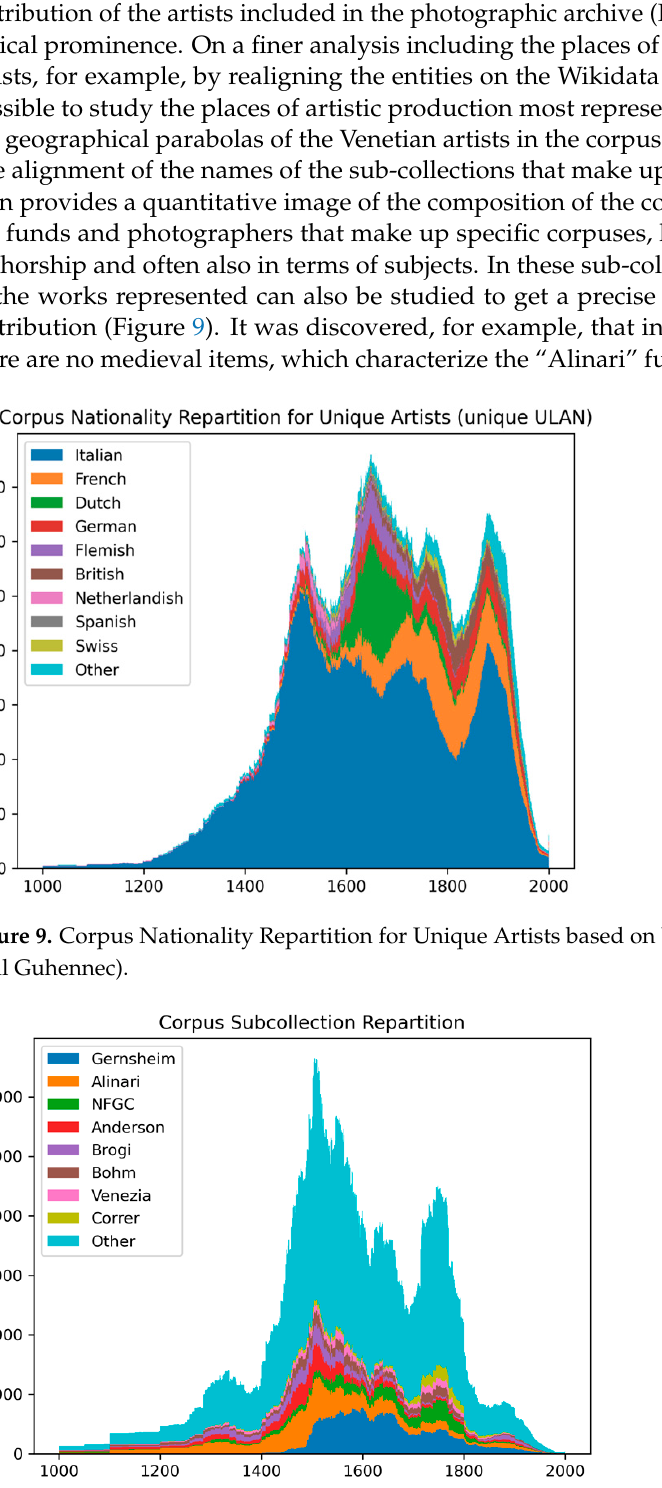
Figure 10. Corpus Temporal Subcollection Repartition (author: Paul Guhennec).